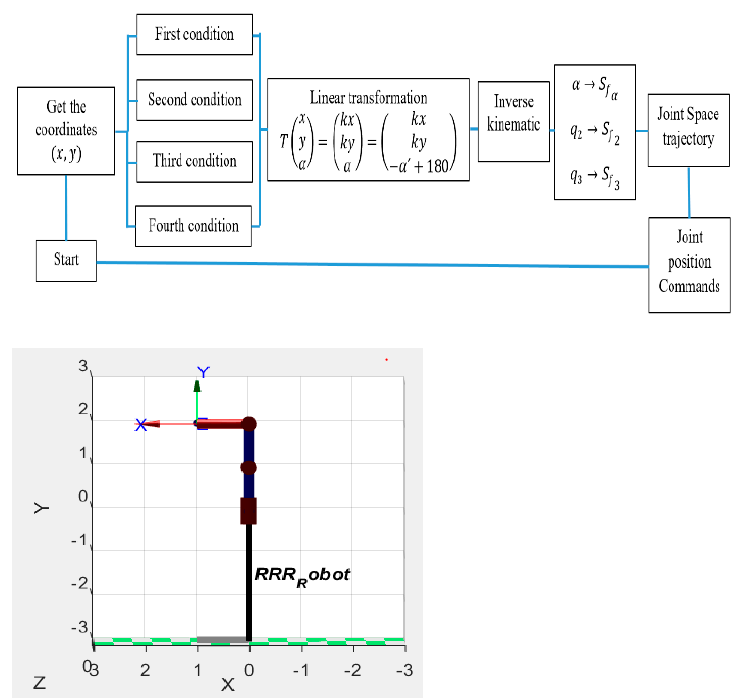
Figure 8. Illustration of the whole process to calculate the trajectory and the position-zero of the robotic arm where q 1 , q 2 , q 3 = 0 wich is presented on the right side and in the task space, the position is x p = 1, y p = 2 and α = 0, so it is had the coordinate (2, 0) with a direction equal to 0.